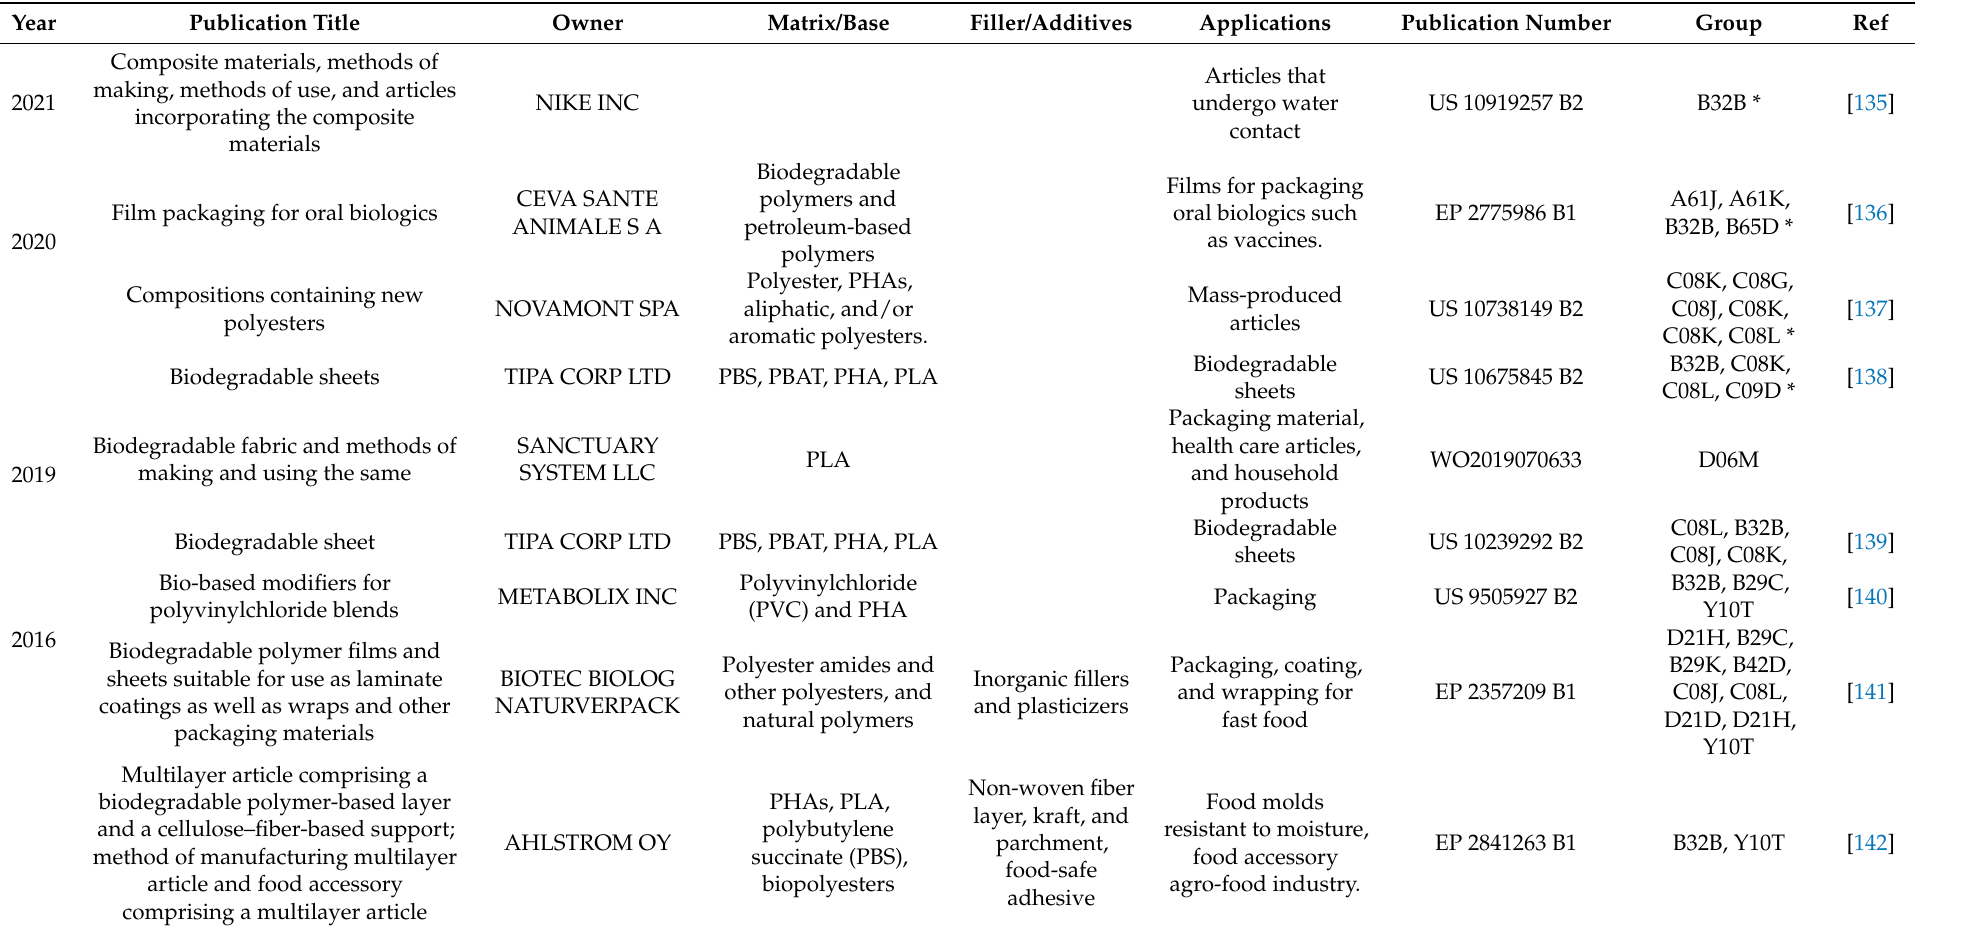
Table 3. Patents of materials with PHAs and natural fibers for packaging or similar